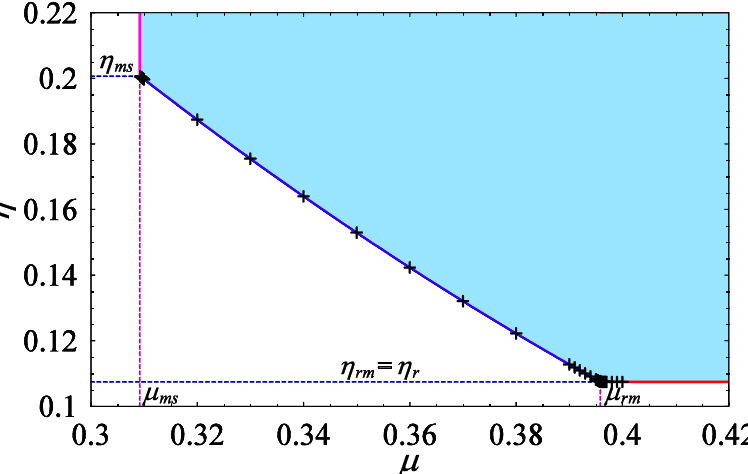
Figure 7: Least thickness to radius ratio  at variable friction coefficient  , obtained by the analytical and numerical analyses. The mixed sliding-rotational mode range,  ms <  <  rm , is limited by  ms = 0.309215 (  ms = 17.1824°) and  rm = 0.395832 (  rm = 21.5952°). The shaded region represents the possible arch equilibrium states of couples (  ,  ). Reducing friction  sets a required increase of least thickness to radius ratio 